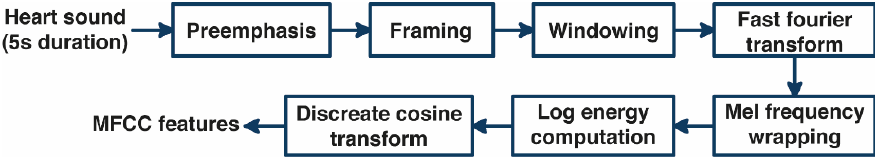
Figure 2. Block diagram of MFCC